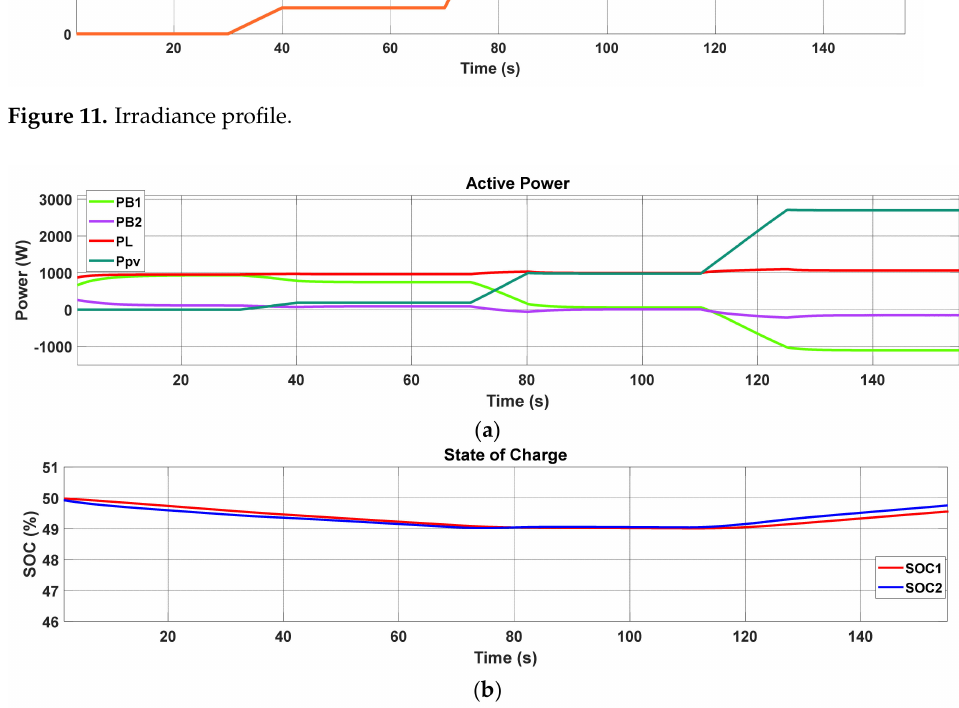
Figure 12. Conventional droop control, ( a ) system power sharing and ( b ) SOC in batteries 1 and 2 at a time of 155